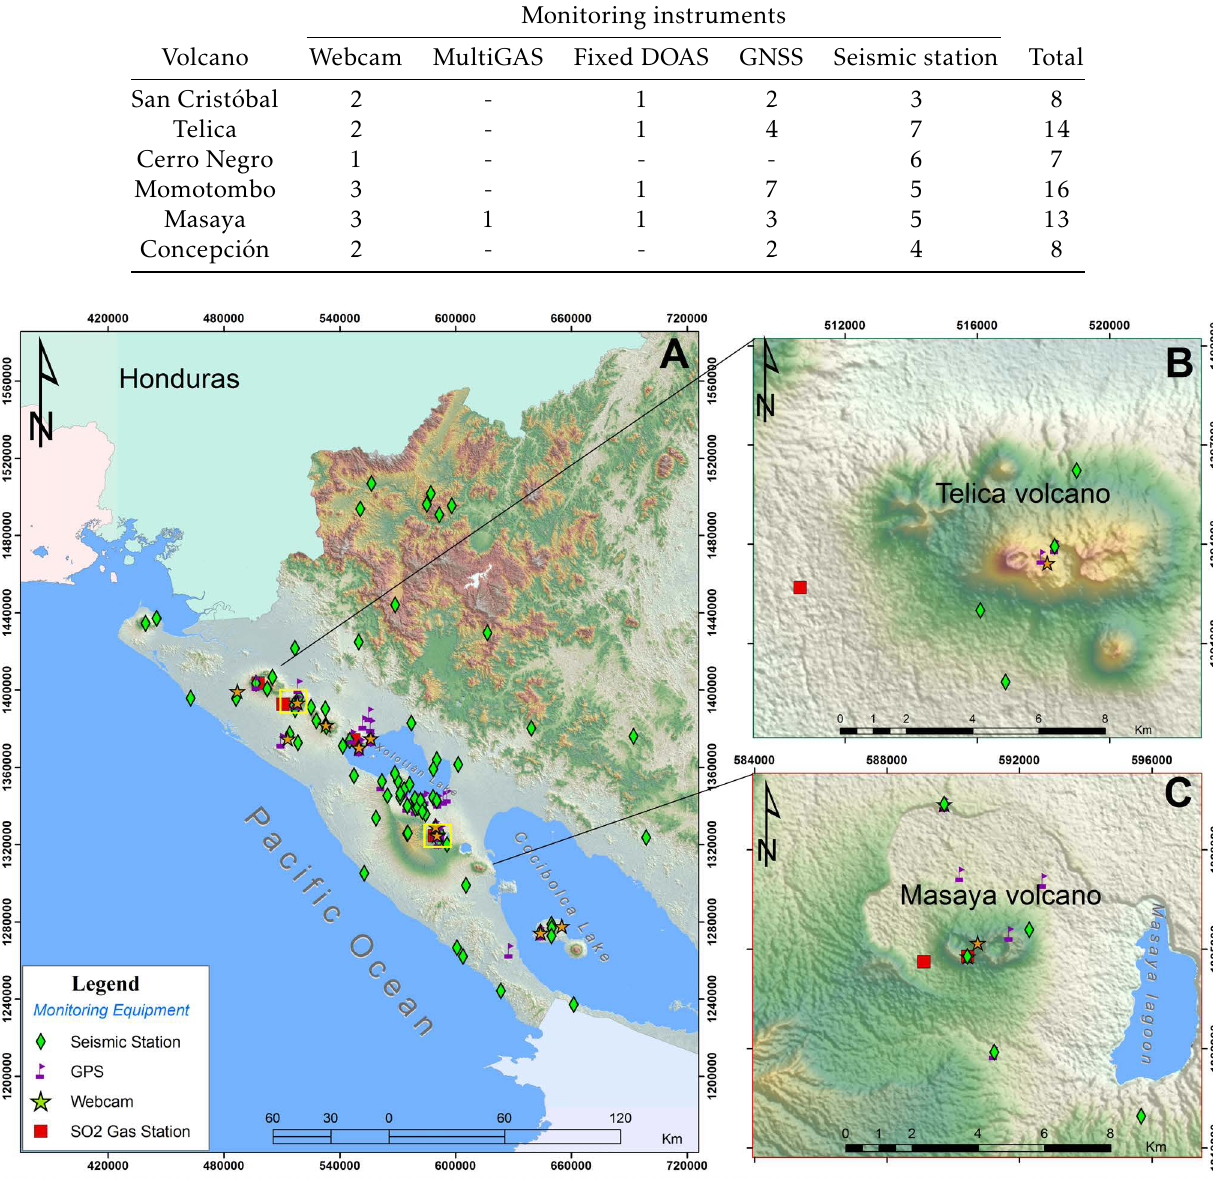
Figure 2: National monitoring network of INETER. Monitoring networks on [B] Telica and [C] Masaya volcanoes. Coordinate system